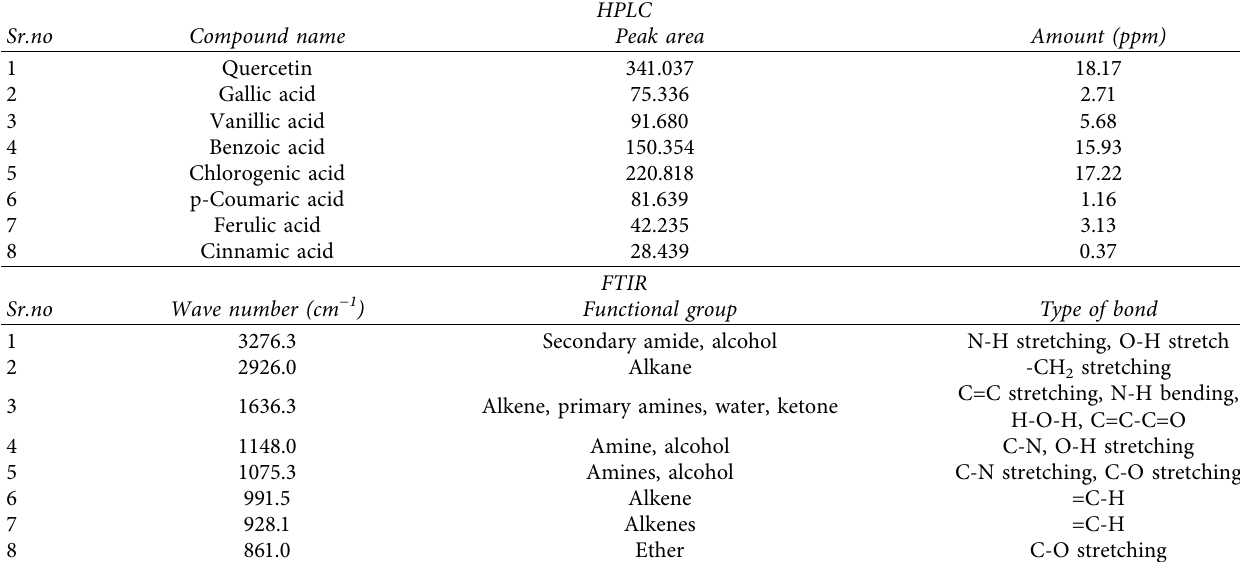
Table 1: Chemical characterization of Zingiber ofcinale .